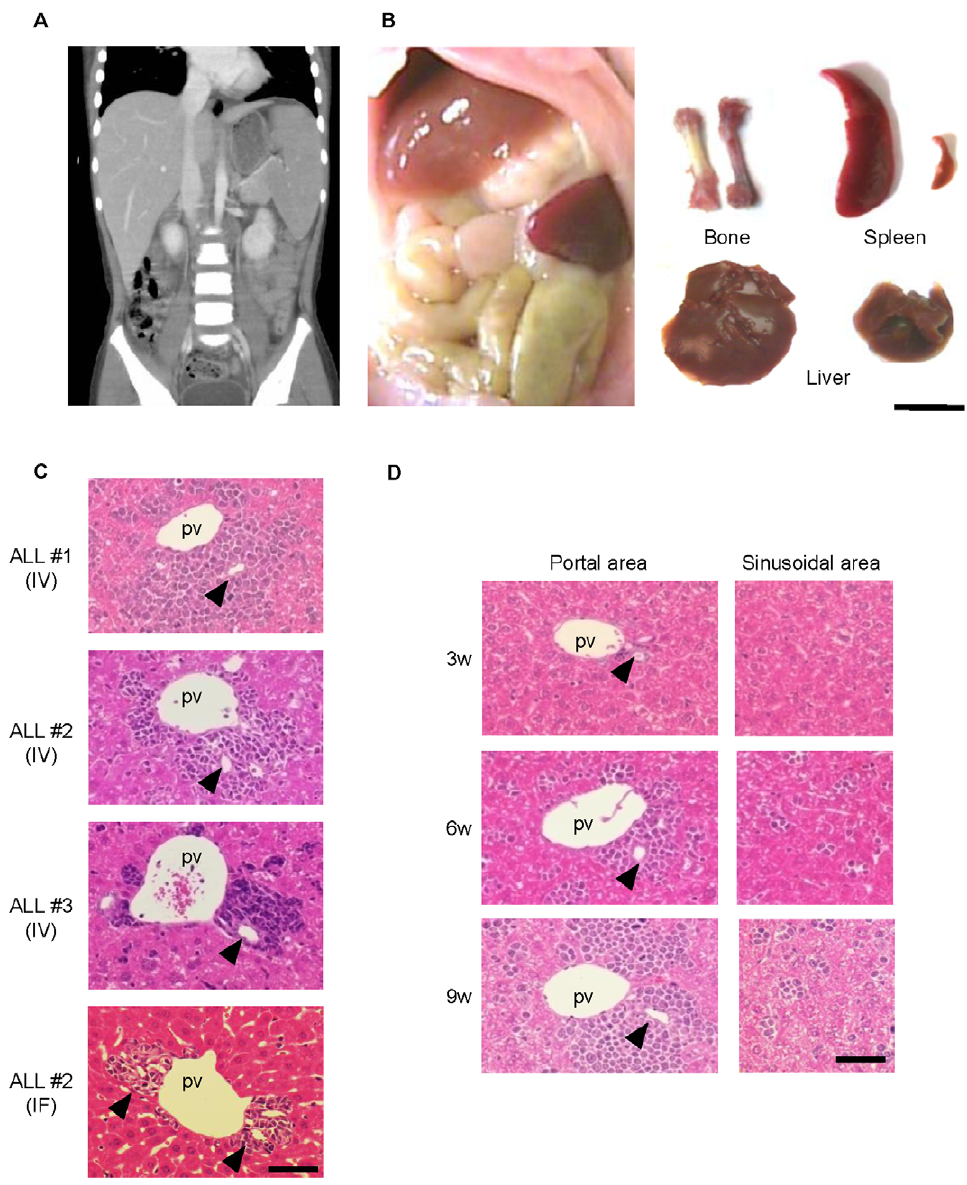
Figure 2. NOG recipient mice transplanted with ALL cells show a clinical leukemic pathology. (A) CT image of patient ALL # 1 abdomen shows hepatosplenomegaly at diagnosis. (B) Macroscopic hepatosplenomegaly of the NOG recipient mouse transplanted with ALL # 1 leukemic cells. Comparison of gross appearance of organs in normal mice (right-hand side) and leukemic NOG mice transplanted with ALL # 1 leukemic cells (left- hand side). Pale femur and enlarged liver and spleen are shown. Scale bar, 1 cm. (C) In all ALL cases analyzed, the corresponding leukemic NOG recipients had large clusters of leukemic cells in portal area. Three representative cases of intra-vein injection and one case of intra-femoral injection are shown. Scale bar, 50 m m. (D) Sequential histopathological analysis of the liver of leukemic NOG mice transplanted with ALL # 1 leukemic cells showed growth of leukemic cell clusters in portal areas (left column), but not sinusoidal areas (right column). Scale bar, 50 m m. pv; portal vein. IV; intra vein injection. IF; intra femoral injection. Arrowheads indicate bile